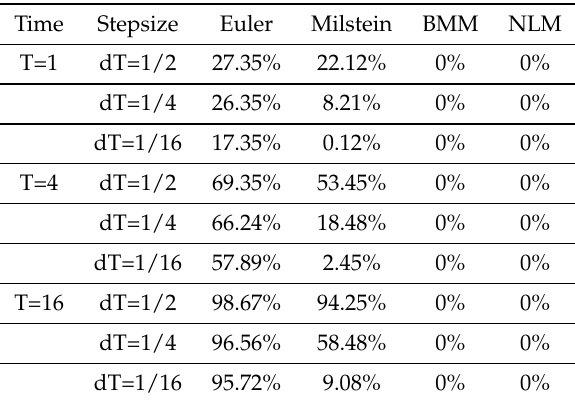
Table 1. Numerical simulation for the equation dX ( t ) = ( 1 − X ( t )) dt + 1.4 interval: [ 0, T ] , stepsize: dT , weight functions of balanced Milstein method (BMM): d 0 ( x ) = 1 + 0.5 ∗ 1.4 2 , d 1 ( x ) = 0, the number of simulated paths: 1500.